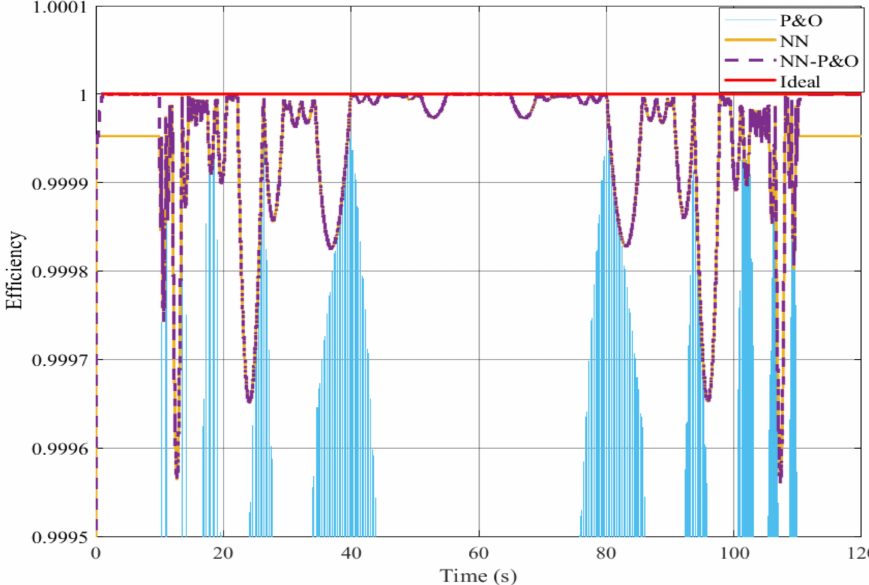
Figure 10. Efficiency of three MPPT methods under a slope of 20 W/m 2 /s.